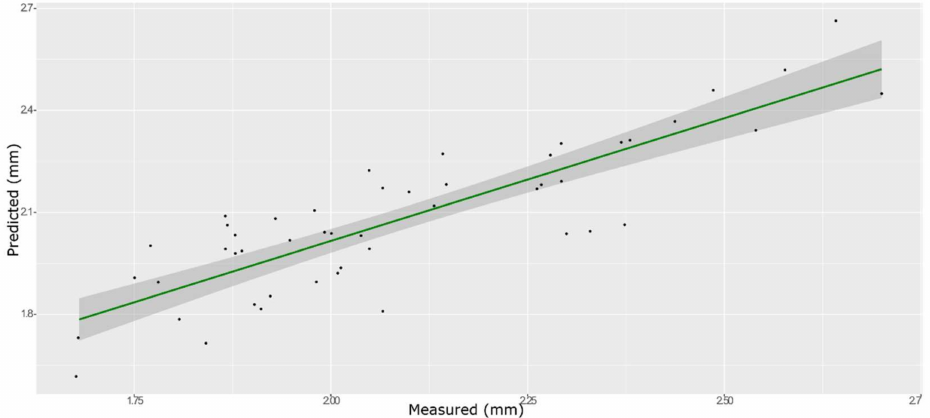
Figure 8. ANN model for BS on the test set, using the selected